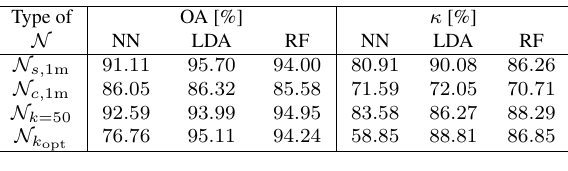
Table 3. Classification results obtained for Oakland-3C when us- ing the downsampled point cloud, four different neighborhood types and three different classifiers.